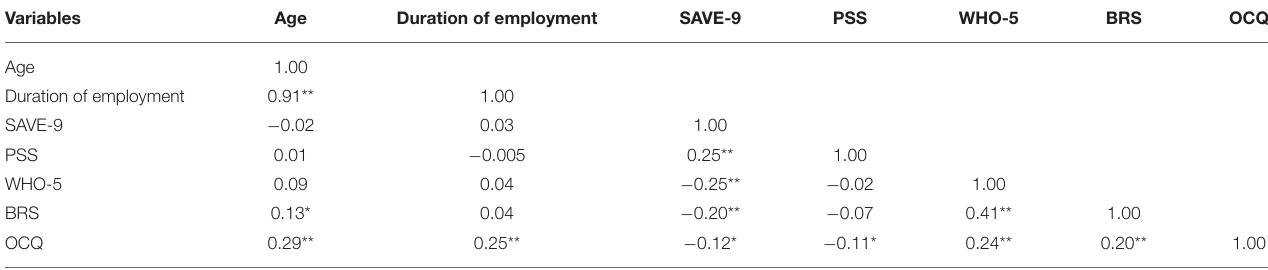
TABLE 2 | Pearson’s correlation coefficients for each variable in all subjects ( N = 389).